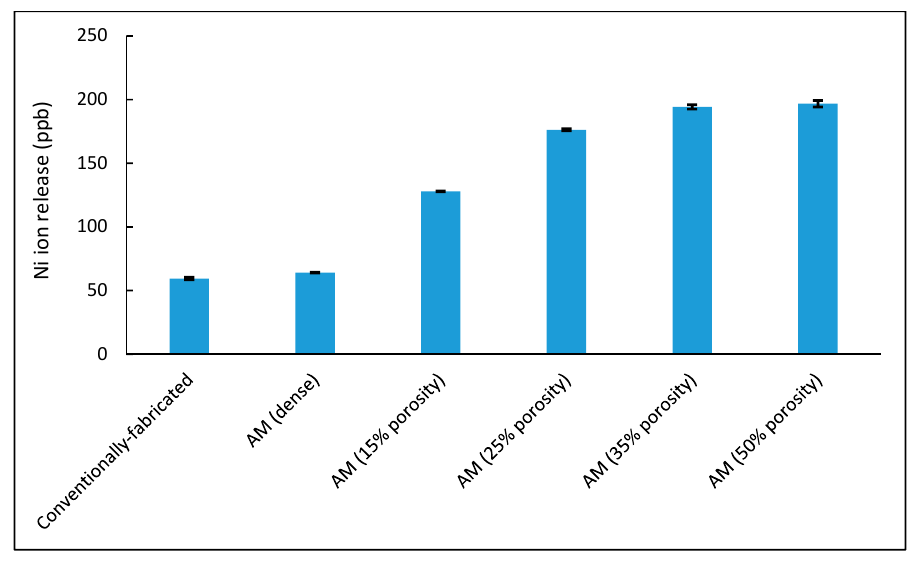
Figure 9. The Ni ion release of two different structures (dense and porous) of additively manufactured NiTi alloys in comparison to the conventionally fabricated NiTi alloy.